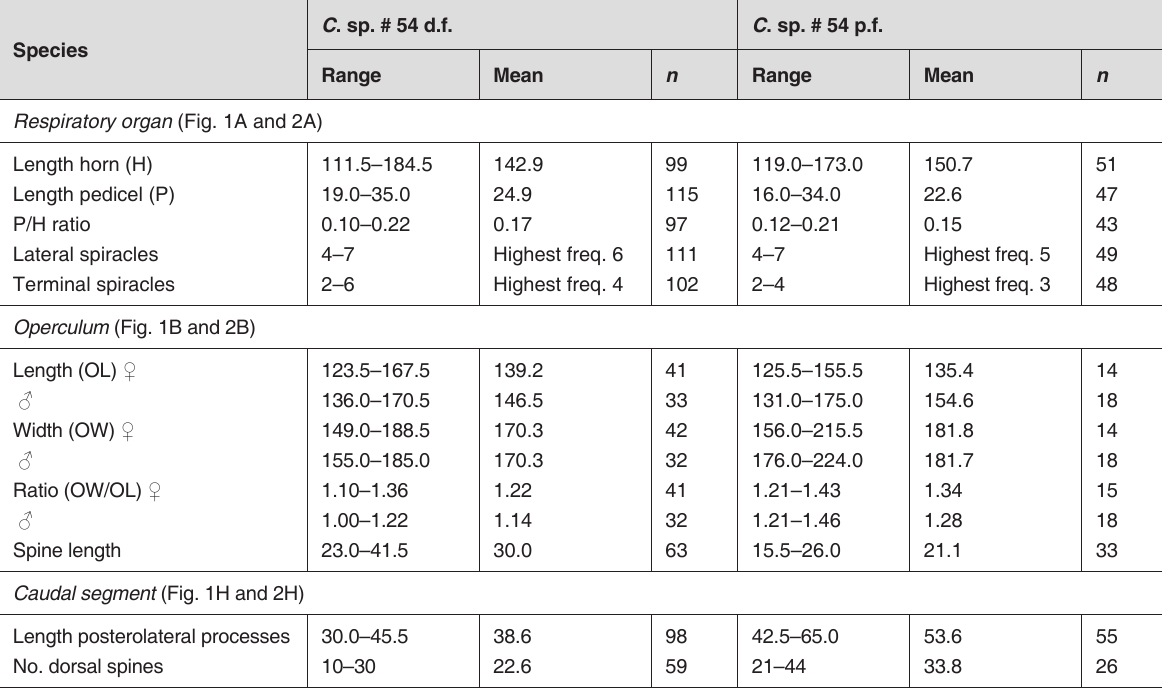
TABLE 1 Measurements (µm), ratios and counts of the morphological characters of the respiratory organ, operculum and caudal segment of the pupae of Culicoides sp. # 54 dark form and Culicoides sp. # 54 pale form C . sp. # 54 d.f. Species